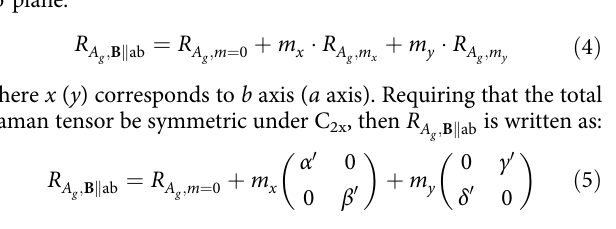
(cid:4) (cid:6) (cid:7) = B 3 = B 3 = I A 5 , labeled I P 2 g g g g (cid:4) (cid:5) (cid:6) (cid:7) = B 3 = I A 5 as a function of applied magnetic fi eld ( B ∥ ab 2 g g for a magnetic fi eld (7 T) applied g